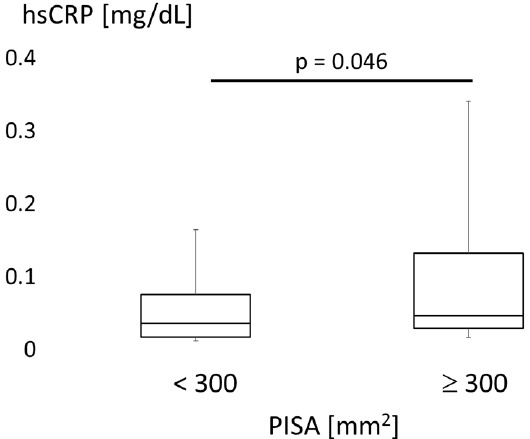
Figure 6. Comparison of high-sensitivity C-reactive protein. High-sensitivity C-reactive protein (hsCRP) is compared between high ( ≥ 300 mm 2 ) and low (<300 mm 2 ) periodontal inflamed surface area (PISA) groups. Box plots show medians, 25th and 75th percentiles as boxes, and 10th and 90th percentiles as whiskers. The Wilcoxon test was used.